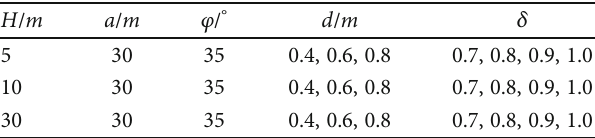
Table 6: Parameters of simulation.